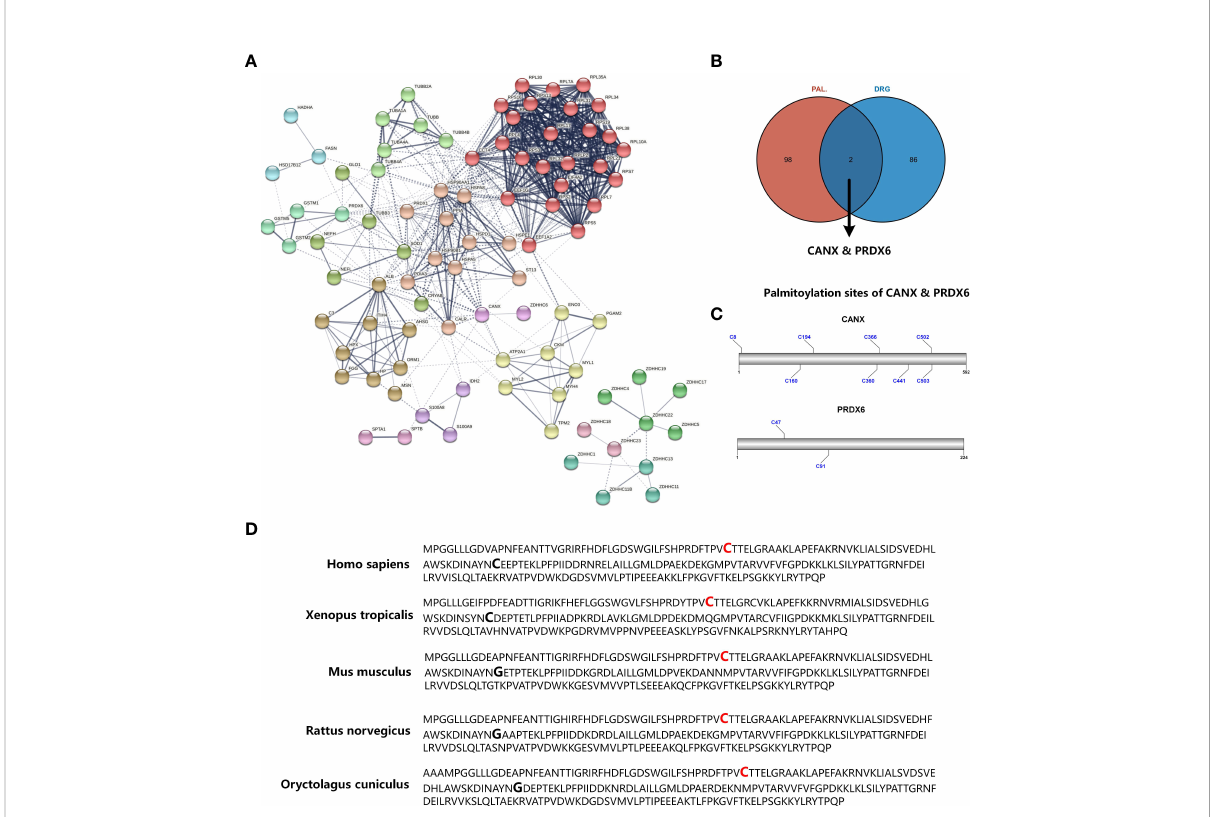
FIGURE 1 Identifying signi fi cant proteins modi fi ed by S-palmitoylation in DRG proteome of diabetic mice. (A) PPI network analysis of differential expression proteins in diabetic mice DRG and the ZDHHC protein family. The edges between each node indicate both functional and physical protein associations, and the line thickness indicates the strength of data support. The edges between MCL clusters were set as dotted lines. (B) Venn diagram showed the mapping results of DRG proteins and S-palmitoylation candidates identi fi ed by acyl-biotin exchange and mass spectrometry. (C) The prediction results of CANX and PRDX6 S-palmitoylation sites. (D) Sequence alignment among the PRDX6 amino residues of Homo sapiens, Xenopus tropicalis, mus musculus, Rattus norvegicus, and Oryctolagus cuniculus. Palmitoylation sites of Cys47 that are conserved in all species are shown in red bold type, and Cys91, not conserved in all species, are shown in bold type only. PPI, protein-protein interaction; MCL, Markov Cluster; DRG, dorsal root ganglia; Cys,